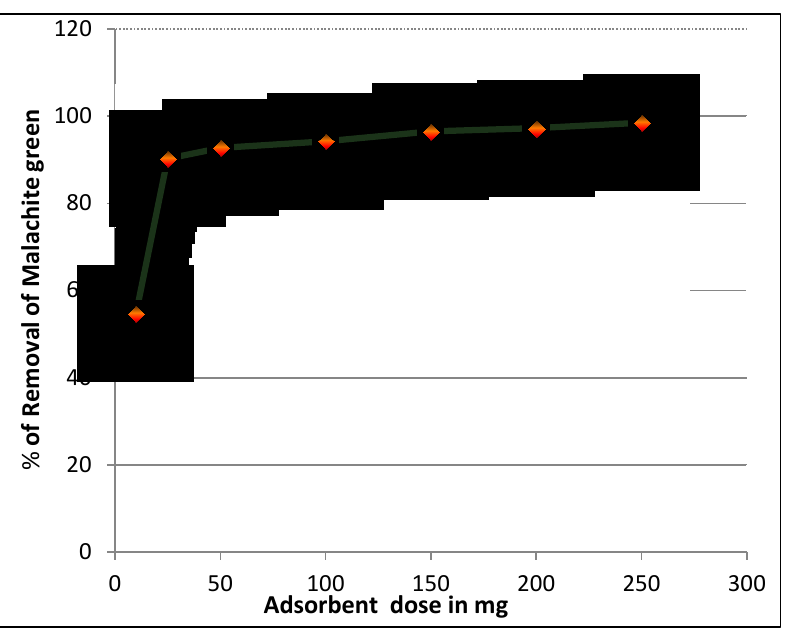
Figure 3. Effect of adsorbent dose on the adsorption of malachite green onto TPC [MG]= 100mg/L: contact time = 60min: